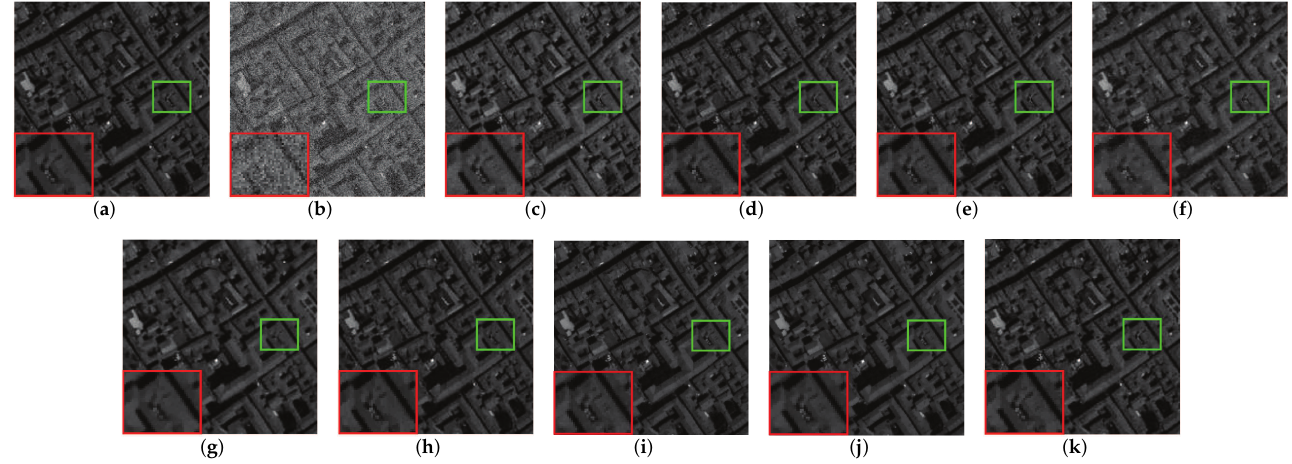
Figure 6. The comparison of the effect of band 30 before and after denoising in the simulated data experiment: ( a ) original image, ( b ) noisy image, ( c ) WNNM, ( d ) LRMR, ( e ) WSNM, ( f ) LRTV,